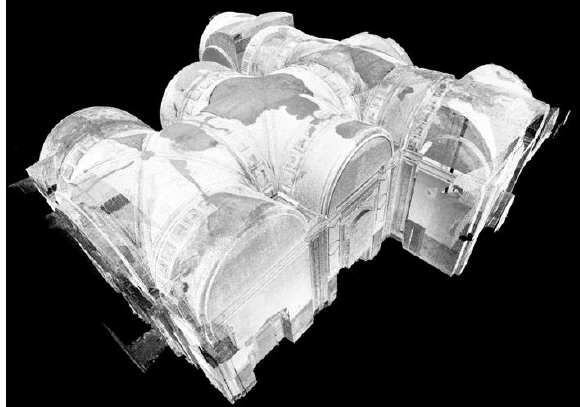
Figure 5. The point cloud of the inner volume of the